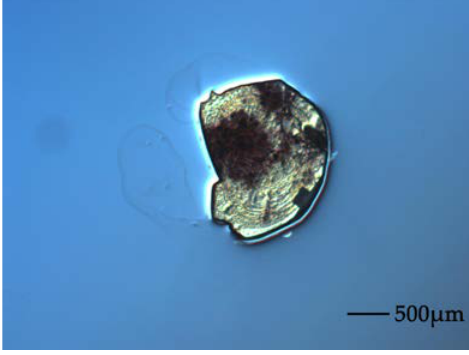
Figure 2. Photograph of the breakthrough on silicon surface.